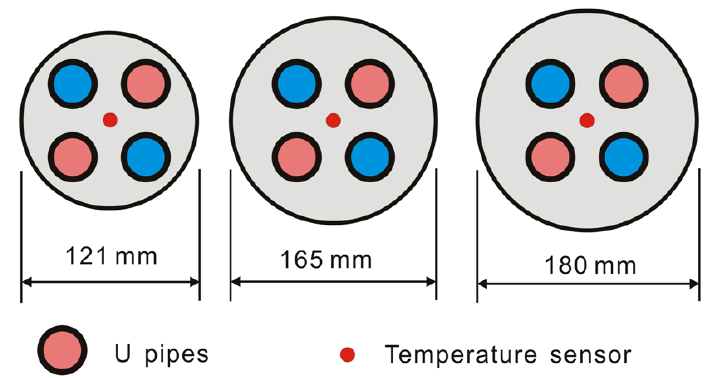
Figure 4. Schematic cross-section of the installed three-block BHEs. The temperature sensors were installed at the center of the BHEs and they are separately located at 18 m, 46.5 m and 77 m below the ground